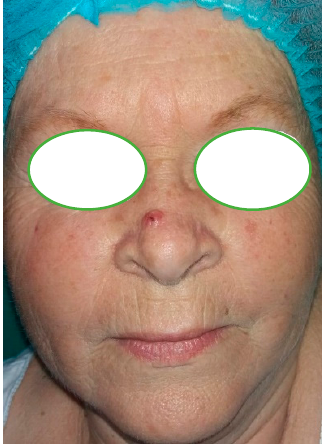
Figure 5. Recurrent squamous cell carcinoma—7 years post-excision.